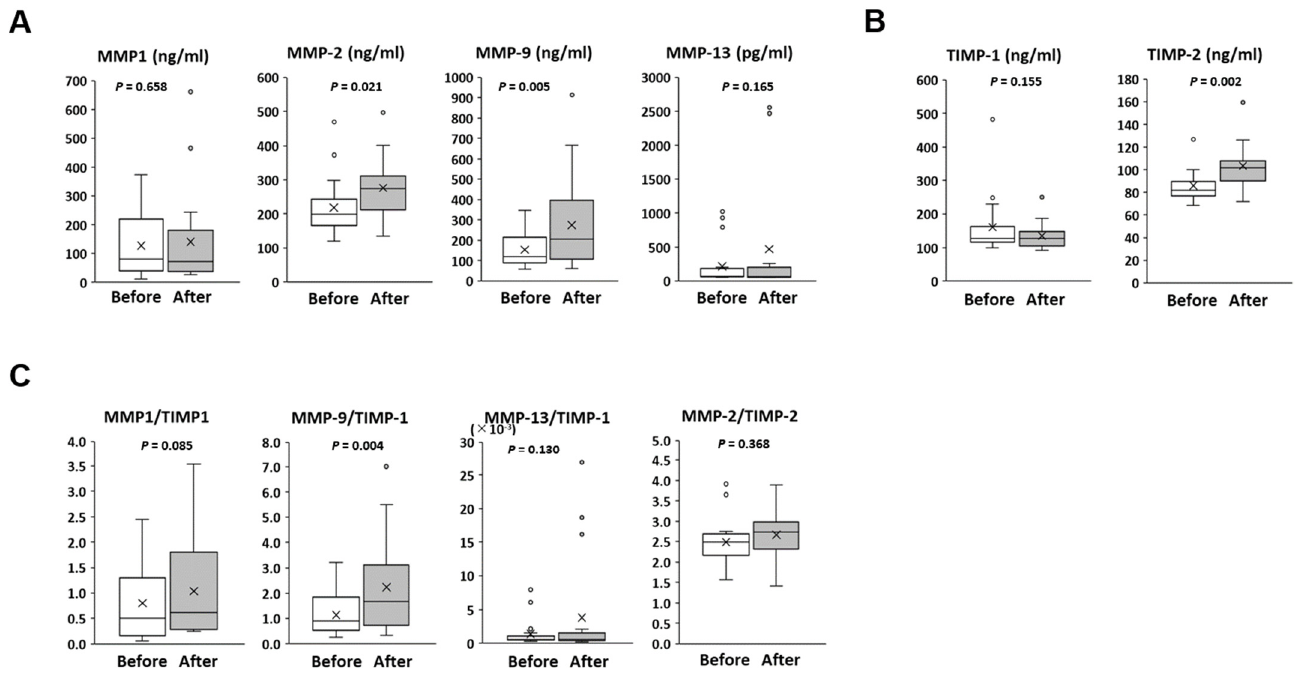
Figure 4. Longitudinal changes of serum matrix metalloproteinase (MMP) and its inhibitor (TIMP) in the patients with zinc elevation. ( A ) Longitudinal changes of serum collagenases level (MMP-1 and MMP-13) and gelatinase level (MMP-2 and MMP-9). ( B ) Longitudinal changes of serum inhibitor of MMP (TIMP-1 and TIMP-2). ( C ) Relative ratios of each MMP and its inhibitor.